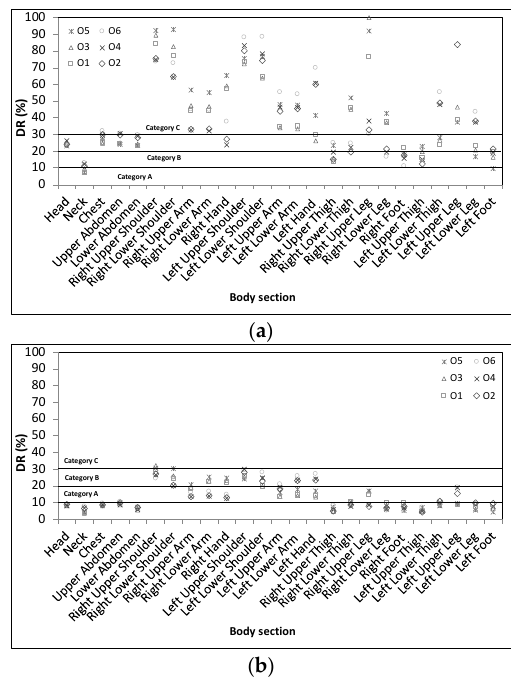
Figure 18. Mean draught risk (DR) value around the 25 human body sections of 6 occupants, for an inlet air temperature of ( a ) 20 °C and ( b ) 24 °C.